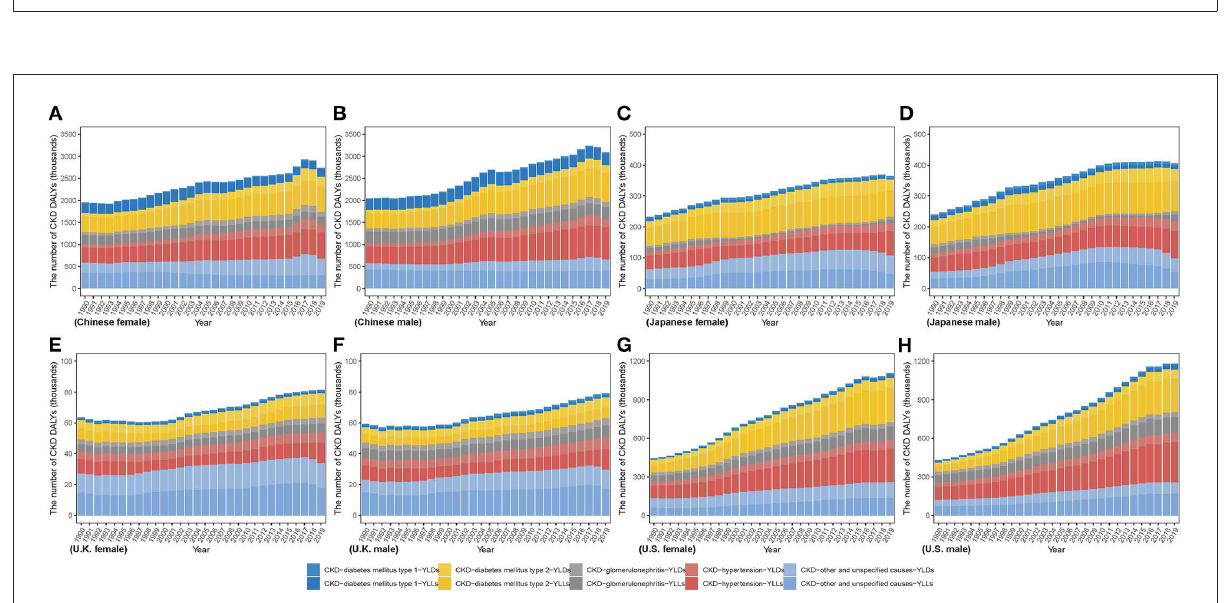
FIGURE5 The number of CKD disability-adjusted life years from 1990 to 2019 in (A) Chinese women (B) Chinese men (C) Japanese women (D) Japanese men (E) U.K. women (F) U.K. men (G) U.S. women (H) U.S. men.